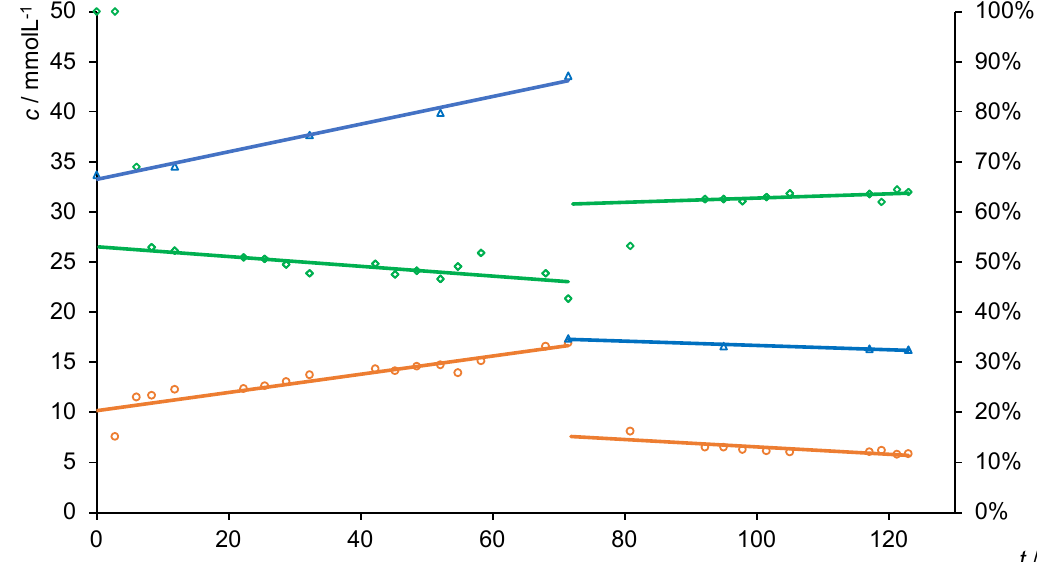
Figure 4. Retentate (blue triangle), filtrate (orange circles) and retention (green triangles) in dead-end (0–70 h) and diafiltration experiments (70–125 h) with sodium gluconate using PILs BD2. Conditions: d membrane = 43.35 mm, p air = 6 bar, Schleicher&Schuell stirred dead-end cell, n [VBuIm]Br = 0.00465 mol, n [VDodecIm]Br = 0.00155 mol, n IL : n ACN : n Styr = 1:3:1, 5wt% TPO, 2wt% DVB (wt% based on m IL ), 0.5 h